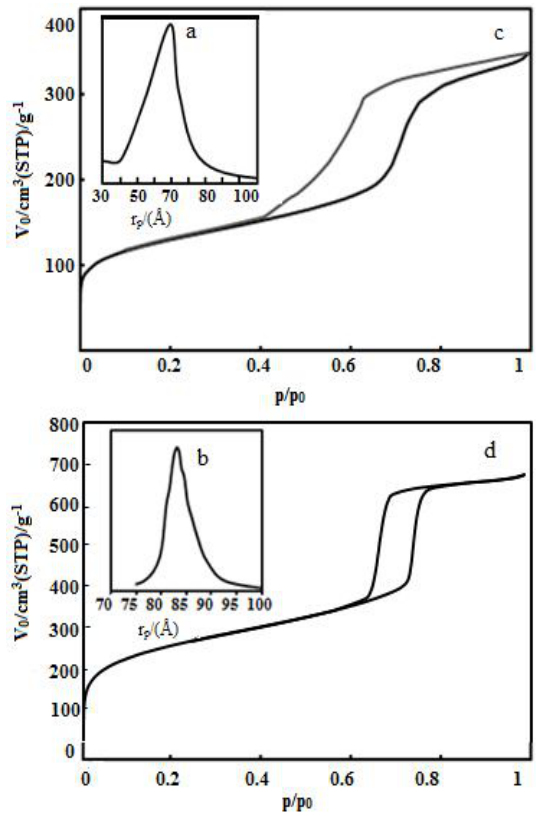
Figure.3. The diagram of pore size distribution (a) BSEA-SBA-15 (b) SBA-15 and N desorption isotherms (c) BSEA-SBA-15 (d)